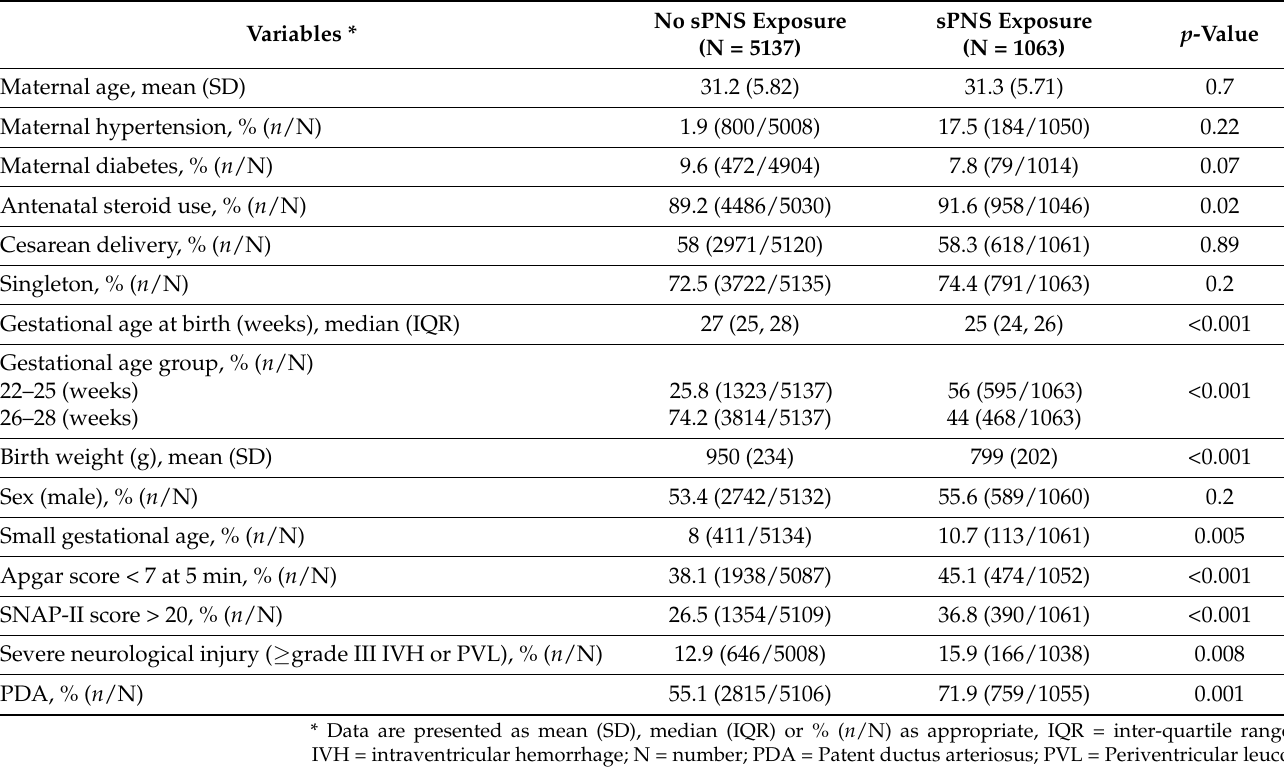
Table 1. Maternal and infant characteristics based on exposure to systemic postnatal